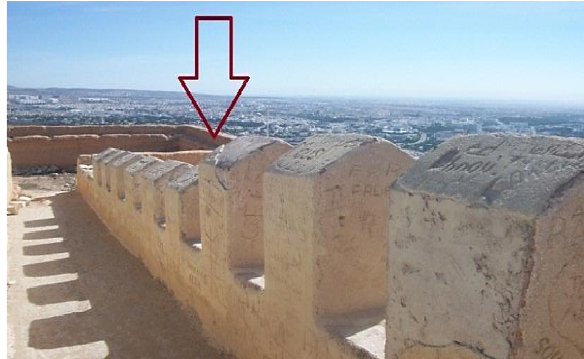
Figure 1. Difference between the height of the crenels of the Kasbah wall.